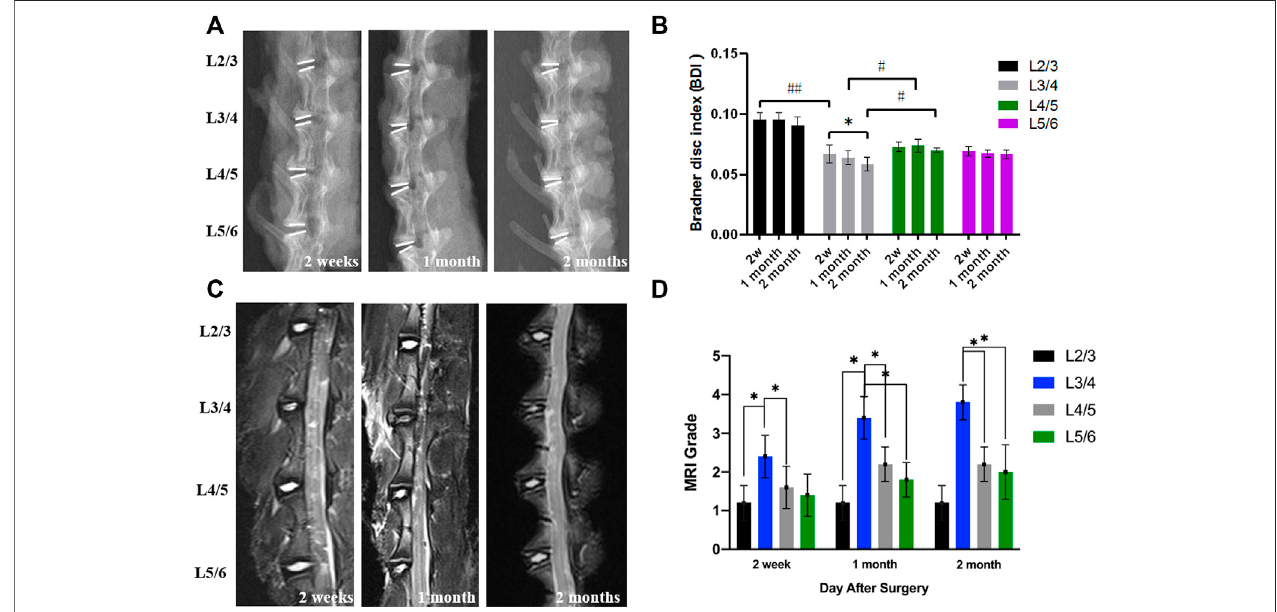
FIGURE 7 | (A) The representative X-ray images. (B) The BDI changes in different groups after surgery. (C) The representative MRI shows the intervertebral disc signal intensity of different groups. (D) The MRI grade changes of different groups after the operation (*,# = p < 0.05).